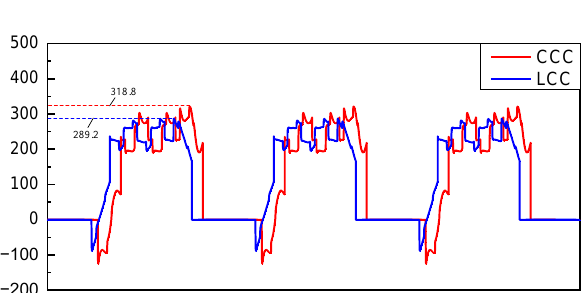
Figure 8. Comparison of the voltage stress across thyristor valves between the CCC and the LCC.